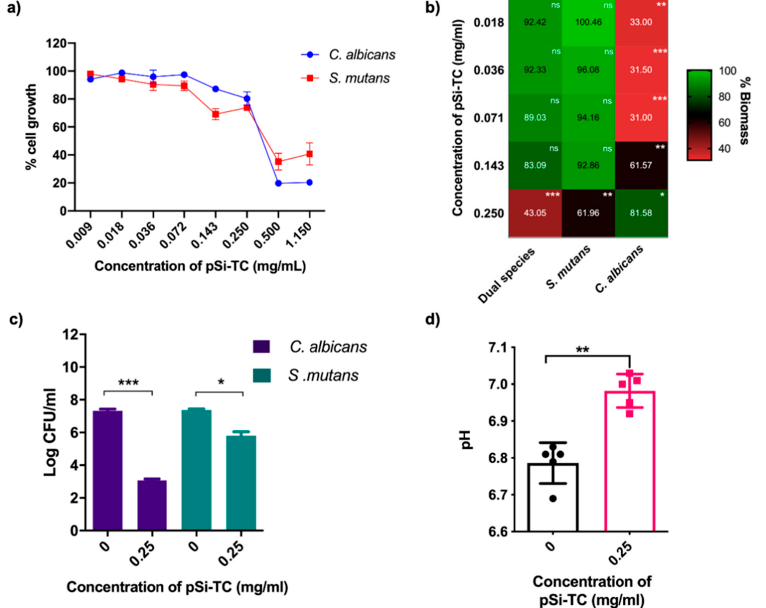
Figure 6. Effect of pSi-TC on ( a ) planktonic S. mutans and C. albicans cultures. Concentrations ranging from 1.15–0.009 mg/mL were tested and showed a reduction in growth at 0.5 and 1.15 mg/mL for both S. mutans and C. albicans when compared to the control, ( b ) heatmap representing the biomass of S. mutans , C. albicans mono-species and in combination, showing significant reduction in biomass when compared to control ( c ) microbial composition of the dual-species biofilm: Log 10 changes in a number of C. albicans and S. mutans after treatment, shows a significant reduction in cell number, ( d ) pH of the spent media showing the reduced acid accumulation when compared to control, denoted by neutral pH when treated with pSi-TC. *** denotes p ≤ 0.0005, ** denotes p ≤ 0.005, * denotes p ≤ 0.01, ns denotes not significant p > 0.05.